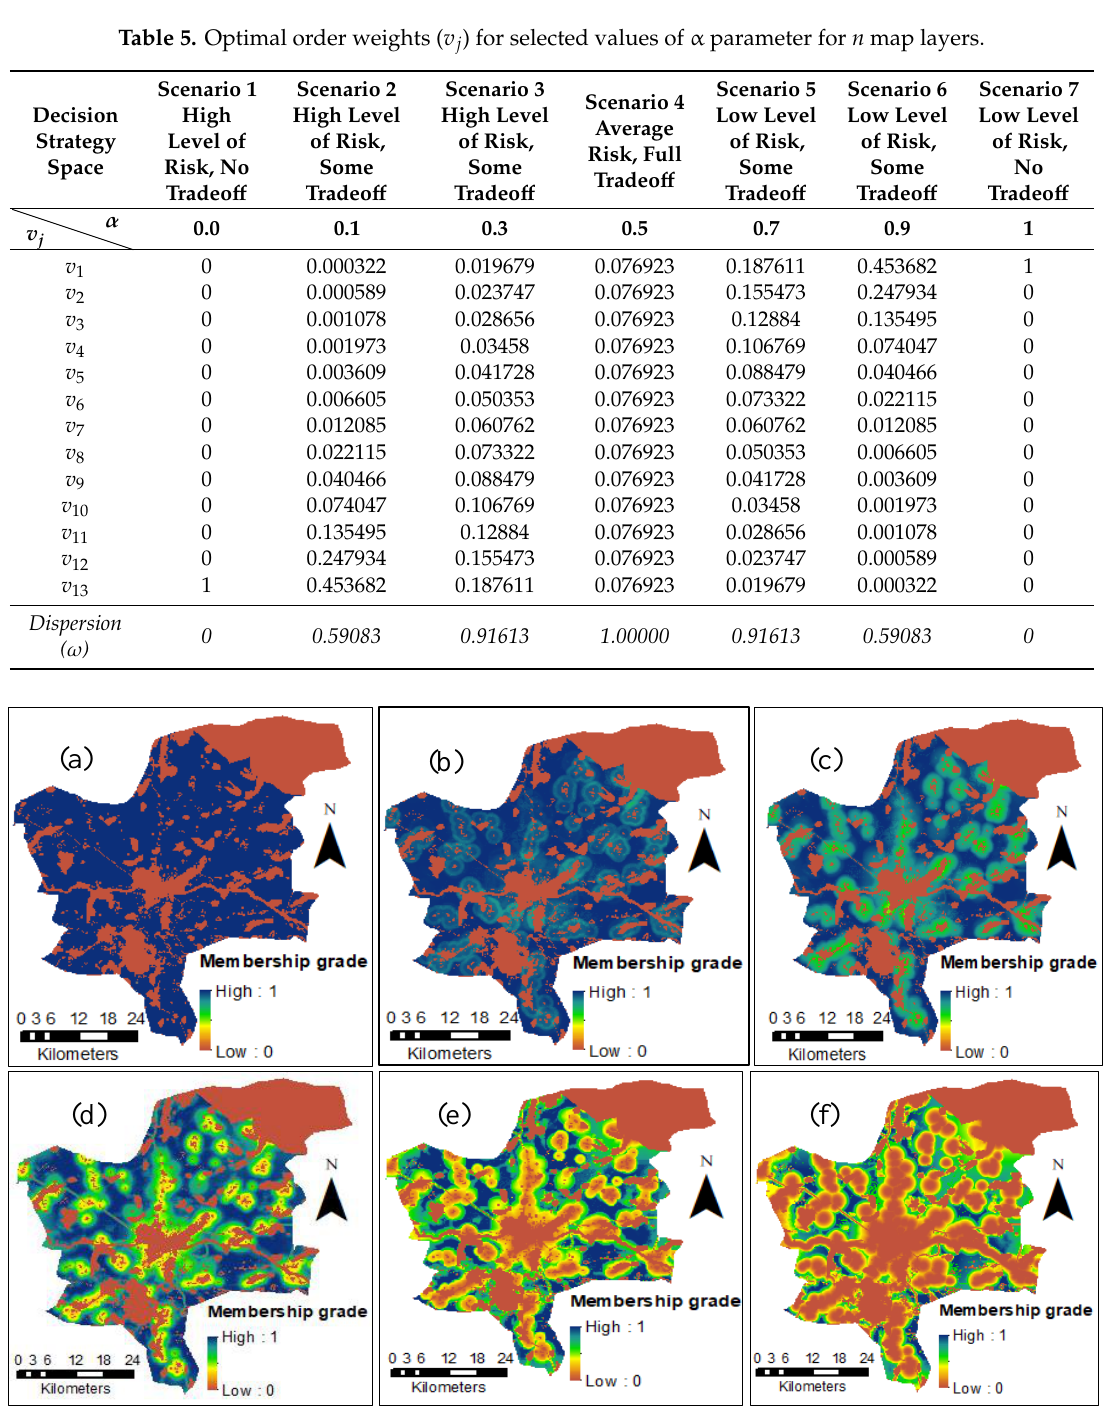
Figure 5. Alternative decision strategies for suitability of landfill sites ( a ) scenario 1, ( b ) scenario 3, ( c ) scenario 4, ( d ) scenario 5, ( e ) scenario 6, ( f ) scenario 7.